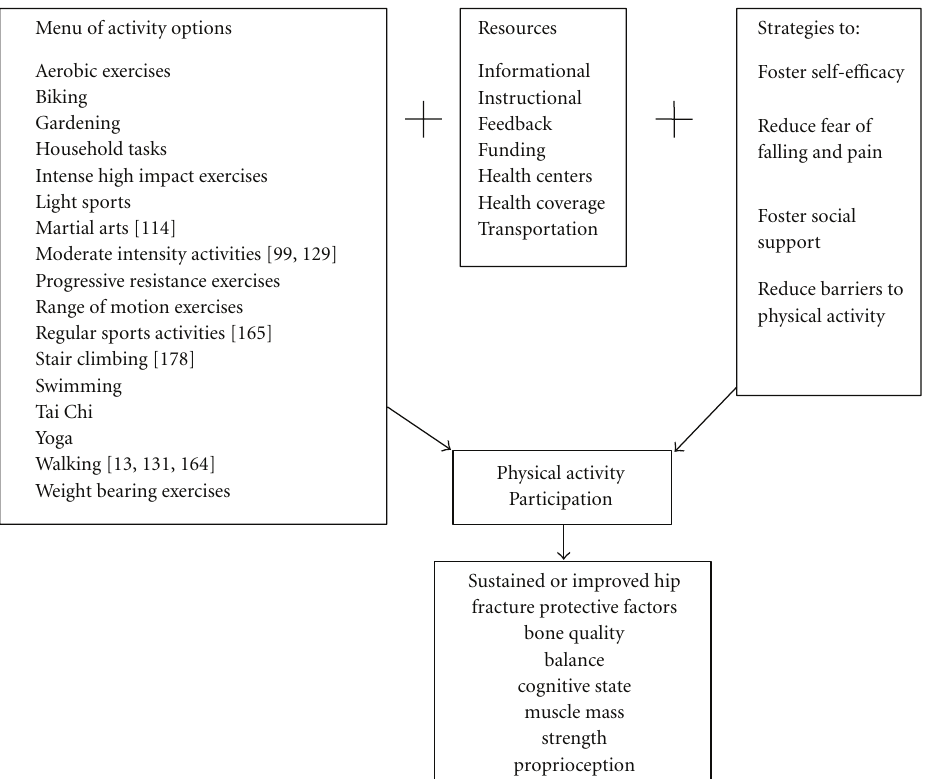
Figure 2: Selected modifiable factors that might facilitate physical activity participation among adults across the